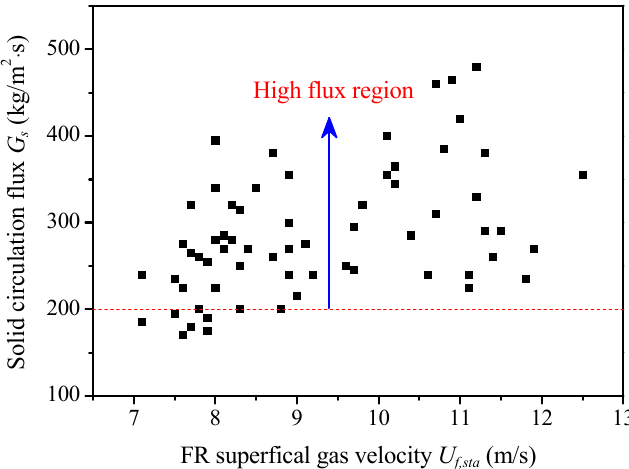
Figure 4. Distributions of the solid circulation flux corresponding to the FR superficial gas velocity.